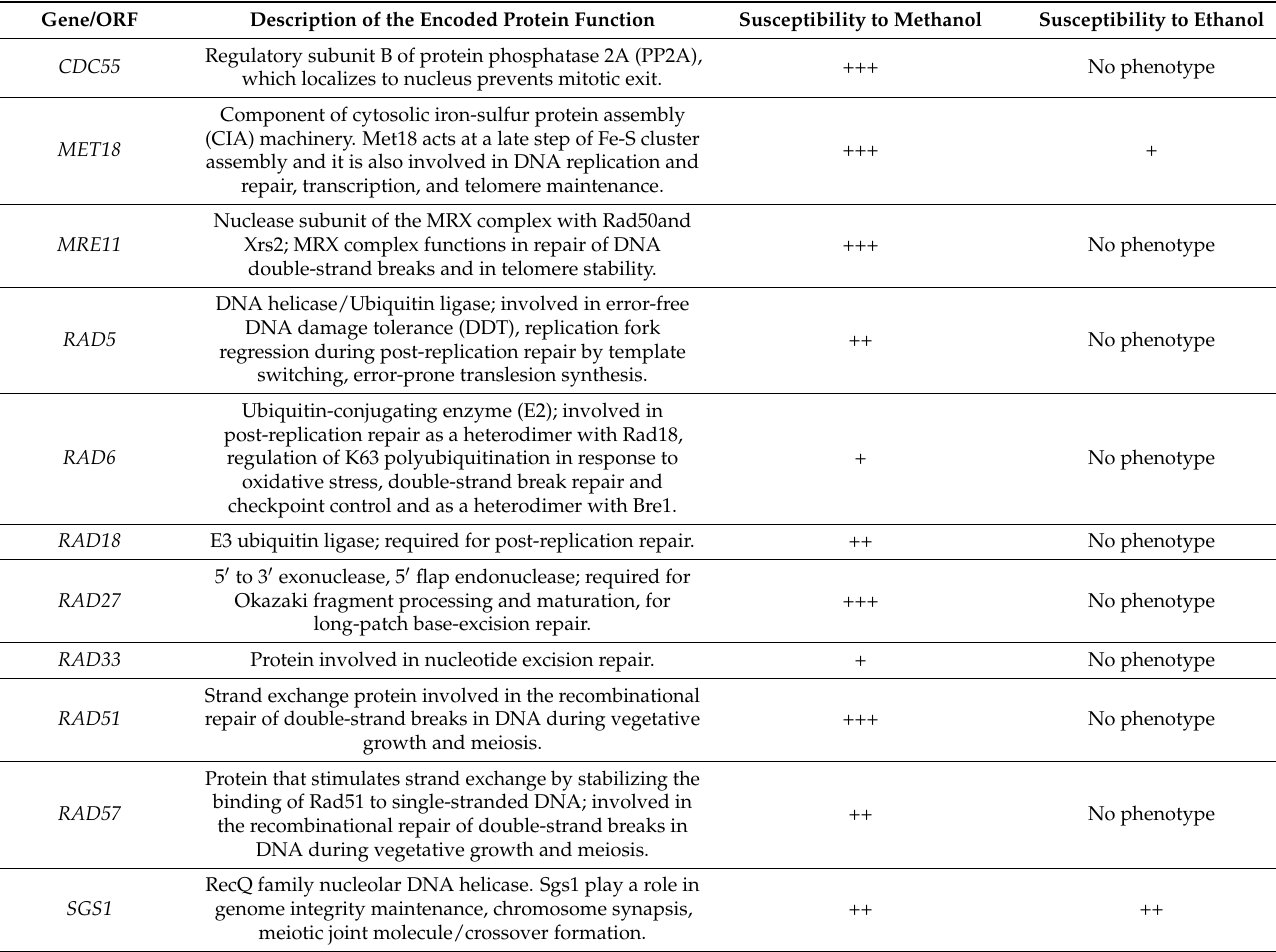
Table 1. Genes involved in DNA repair and mitotic cell cycle identified in this study as determinants of yeast tolerance to methanol, compared with ethanol. The description of the encoded protein functions is based on the information at SGD (www.yeastgenome.org). The classification of the susceptibility phenotype level is as described in the Section 2. Gene/ORF Description of the Encoded Protein Function Susceptibility to Methanol Susceptibility to Ethanol